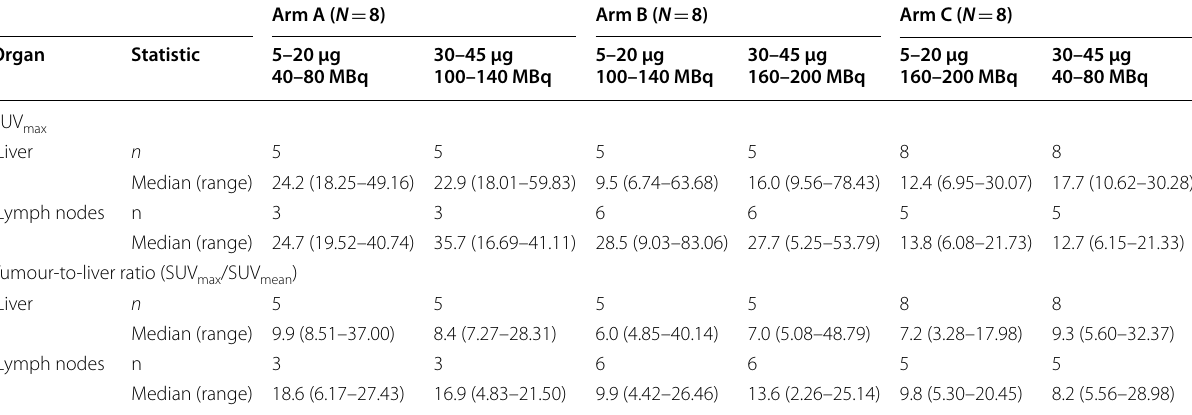
Table 4 SUV and tumour-to-liver ratio for the liver and lymph nodes, by combination max